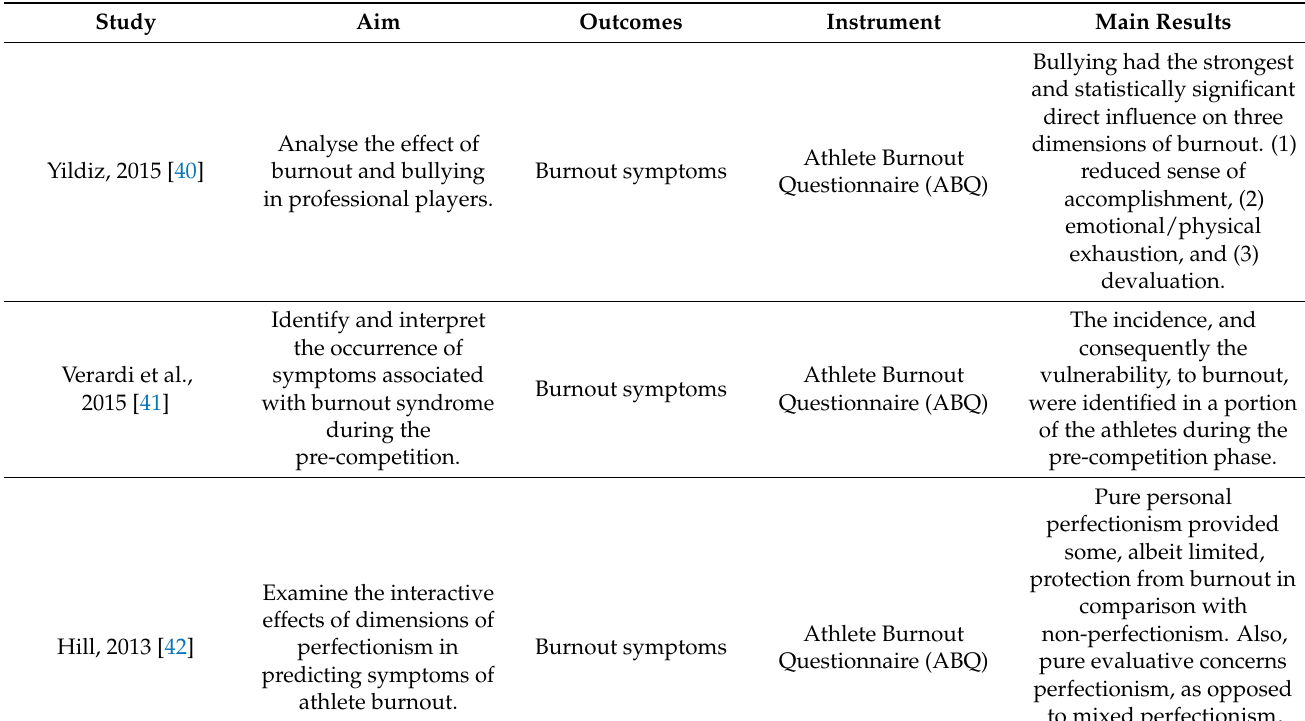
Table 5. A qualitative synthesis of the studies related to